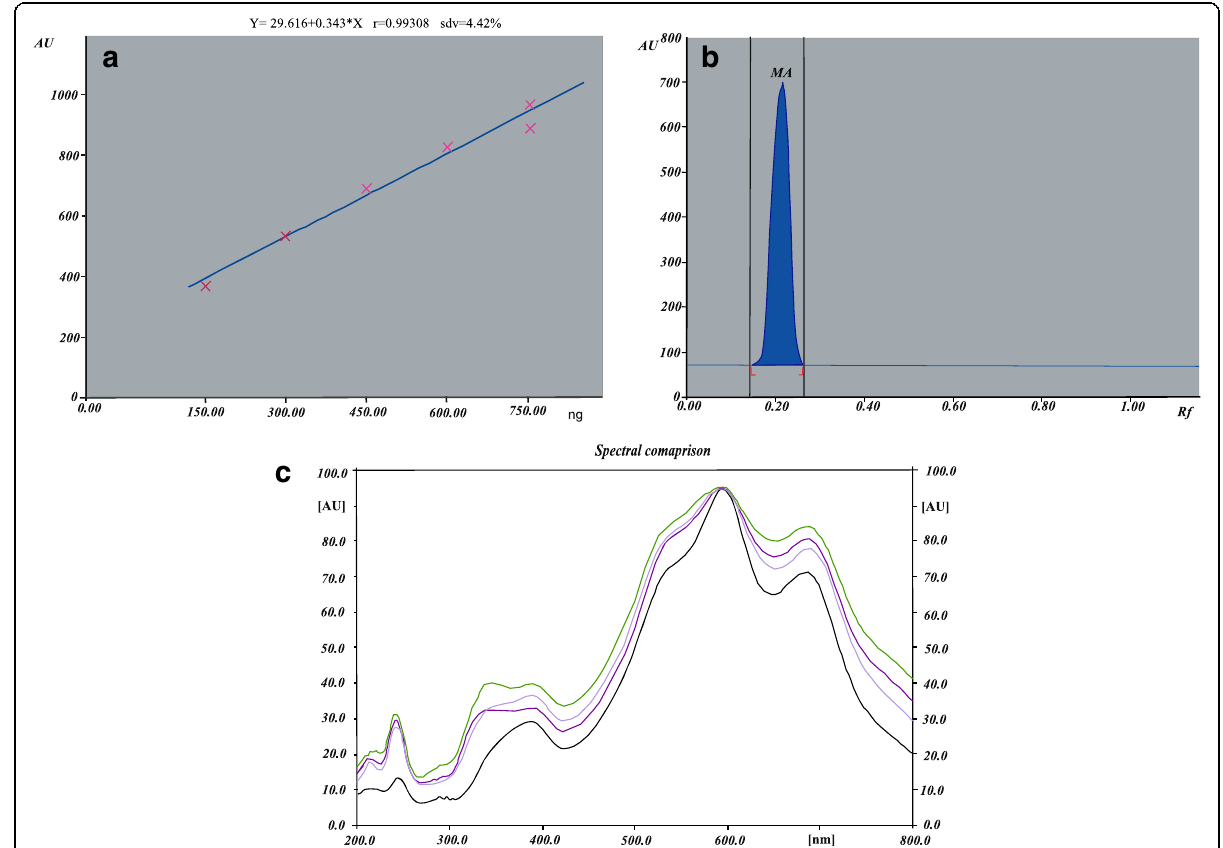
Fig. 1 a Linear range of calibration plots for galangin; b Standard galangin used as a phytomarker; c Overlaid spectra of standard galangin and three species of